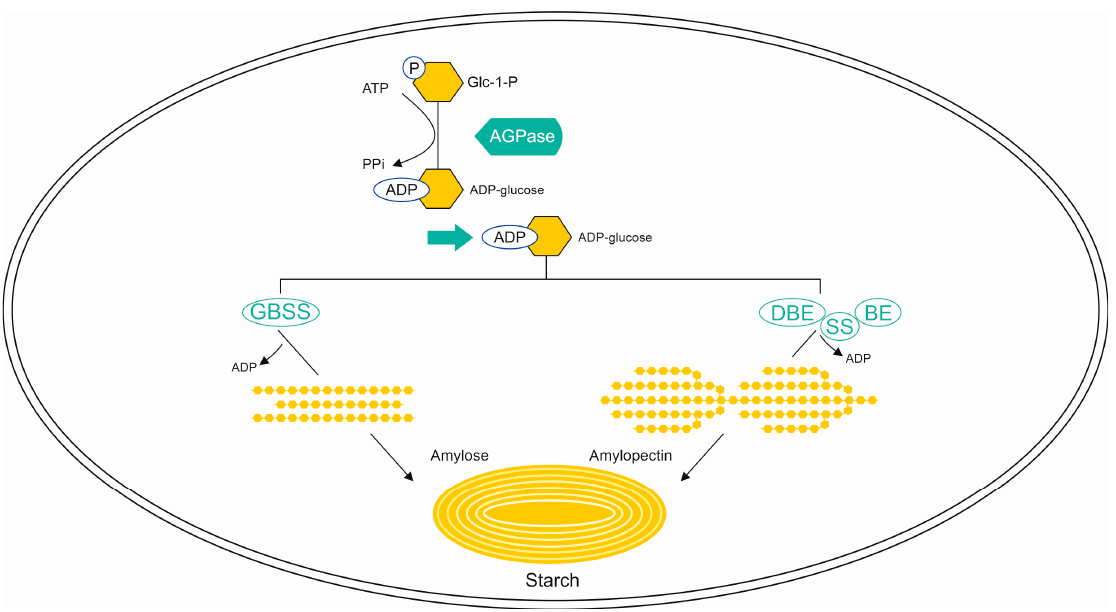
Figure 2. Diagram summarizing the pathway of the formation of the wheat starch granule. In amylo- plast, the amylose is synthesized by granule-bound starch synthase (GBSS), while amylopectin biosyn- thesis requires three more coordinated enzymes of soluble starch synthase (SS), starch-branching enzyme (BE), and starch-debranching enzyme